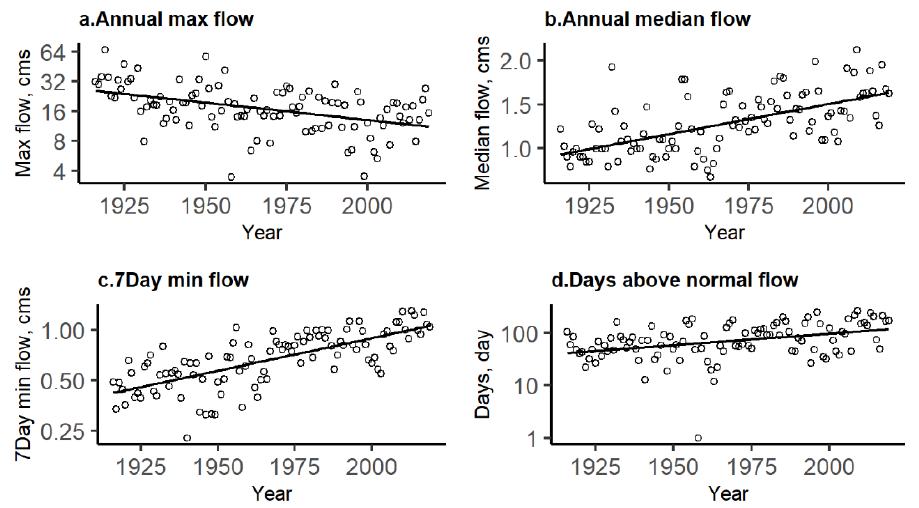
Figure 3. Streamflow regime of the Cataract (rural) gauge located in the main channel. ( a ) Annual max flow, ( b ) Annual median flow, ( c ) 7-day min flow, ( d ) Days above normal flow.